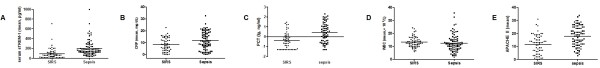
Comparison of diagnostic values for sepsis. The diagnostic values of sTREM-1, CRP, and PCT levels; WBC count; and APACHE II score for sepsis on the day ICU admission were compared. The dots denote individual values, and the bars denote means